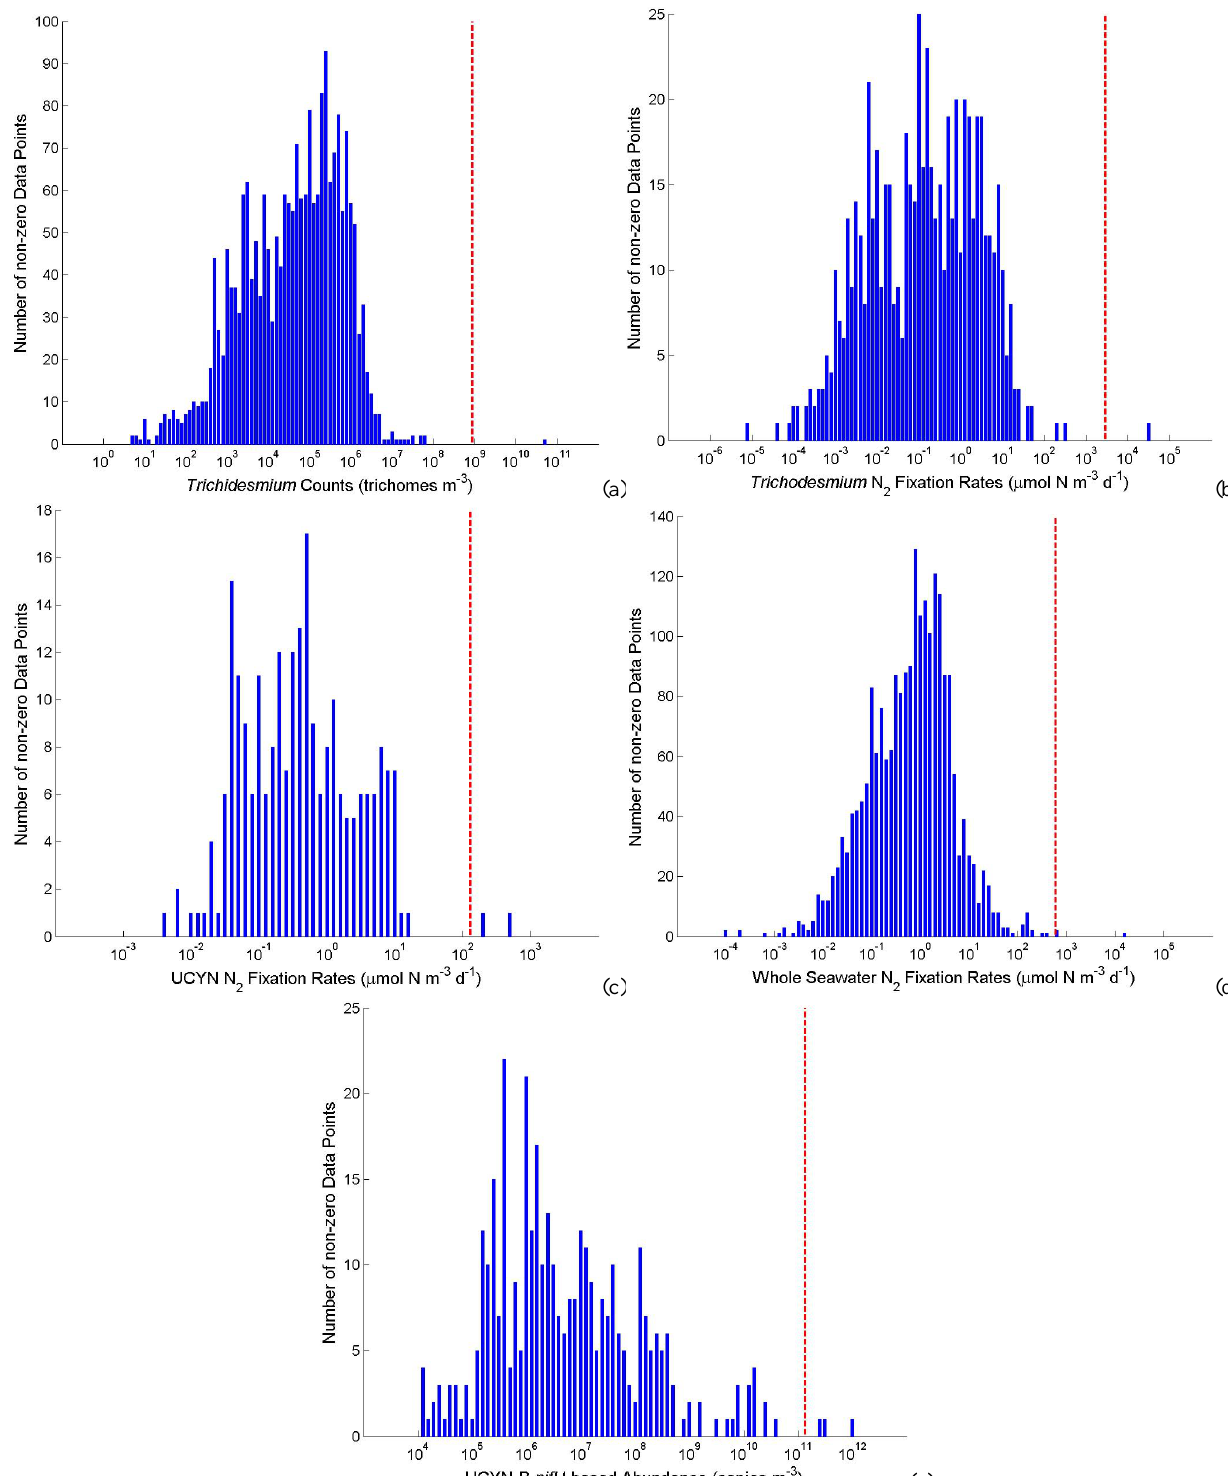
Figure 2. Histogram of data points on logarithmic scale (blue bars) and the critical values for quality control using Chauvenet’s criterion (dashed red lines). Values higher than the critical values are rejected. (a) Trichodesmium cell counts, (b) Trichodesmium N 2 fixation rates, (c) UCYN N 2 fixation rates, (d) whole seawater N 2 fixation rates, and (e) UCYN-B nifH -based abundance. See Supplement Fig. S1 for figures for other